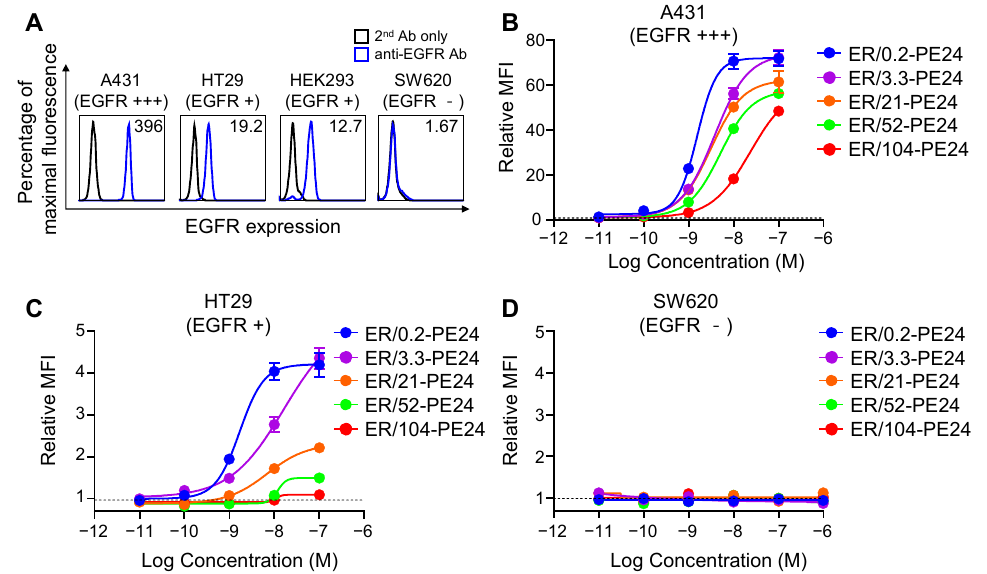
Figure 2. Cell surface binding activities of ER-PE24 ITs based on the affinity for EGFR and EGFR expression levels on cells. ( A ) Representative histograms showing EGFR expression levels on the surface of indicated cell lines determined using flow cytometry. Negative control was used only with the secondary antibody (2nd Ab only) without the anti-EGFR primary antibody. The relative mean fluorescence intensity (MFI) was calculated by comparison with the MFI of negative control and is presented in each histogram. ( B–D ) Concentration-dependent cell surface binding activities of ER-PE24 ITs to three different cell lines, EGFR high-expressing A431 cells ( B ), EGFR low-expressing HT29 cells ( C ), and EGFR negative SW620 cells ( D ), determined by flow cytometry. The relative MFI was calculated by comparison with the MFI measured with or without ER-PE24 (indicated by the dashed black line). In ( B – D ), each value represents the mean ± SEM ( n = 3).